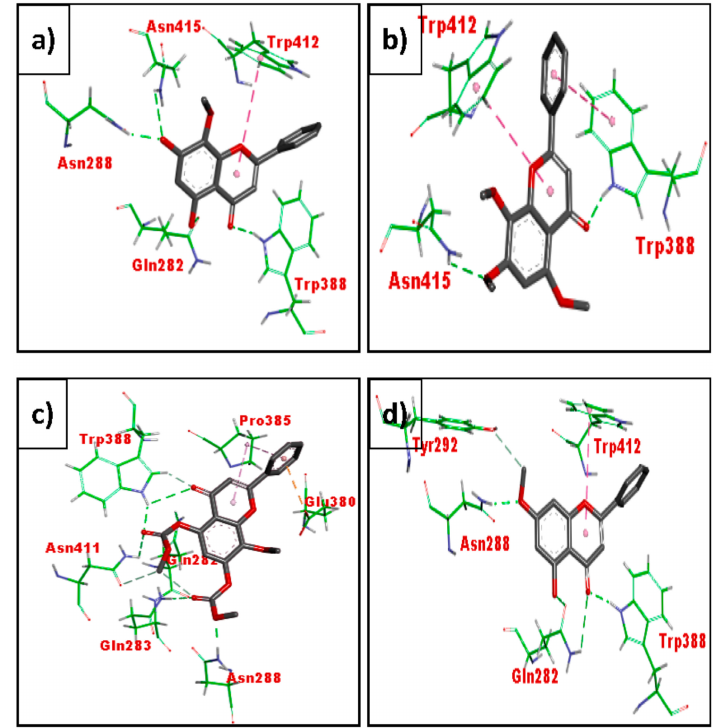
Figure 13. Binding interactions of wogonin (MN1) ( a ), methyl ether of wogonin (MN2) ( b ), acetate of wogonin (MN3) ( c ), and techtochrysin (MN4) ( d ) with active site residues of GLUT1 (PDB ID: 5EQI). The compounds are coloured black while amino acids are green. Green and purple dashes depict hydrogen bond and hydrophobic bond,